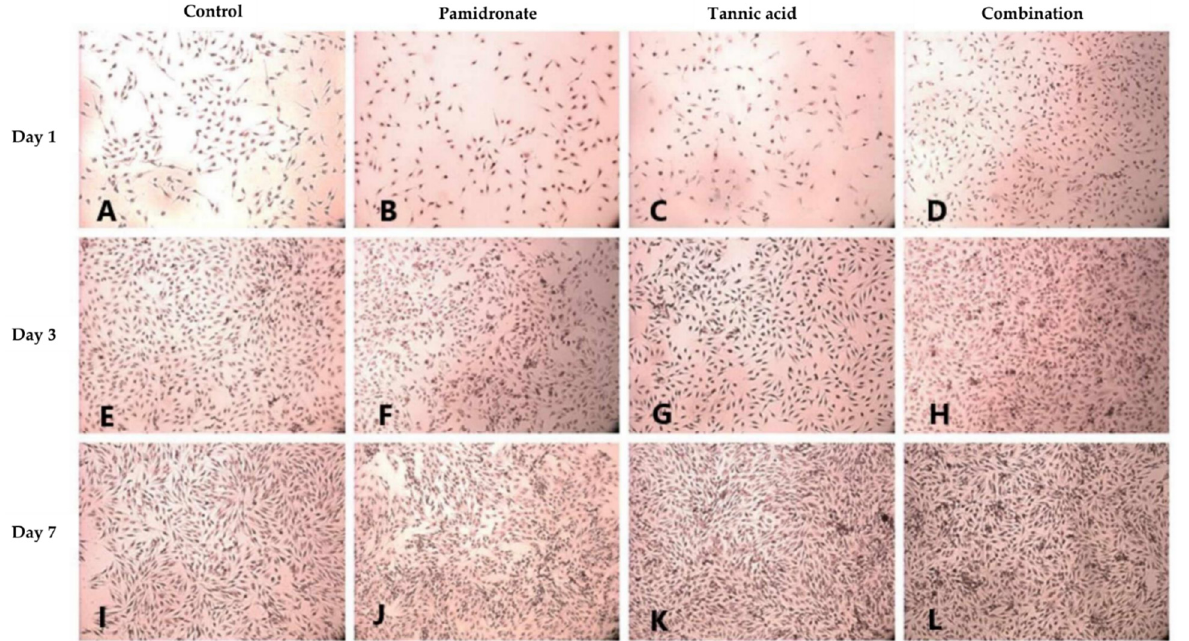
Figure 3. Alizarin red S (ARS) staining is used to evaluate calcium-rich deposits by cells in culture ( A – L ). ARS staining for calcium (Ca) deposits in hFOB 1.19 cells for 1, 3, and 7 days in the control group (DMSO treated), tannic acid (TA)-treated group, pamidronate (PAM)-treated group, and the combination of TA and PAM (75:25) observed using an image analyzer (magnification: 22×). ARS reveals the presence of Ca in mineralizing cells by forming a red–orange spots calcium complex.